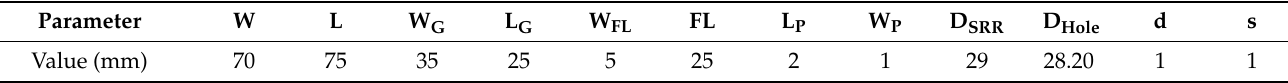
Figure 1. Microstrip patch sensor geometry and dimensions: ( a ) top view and ( b ) bottom view. Table 1. Geometrical parameters of a microwave